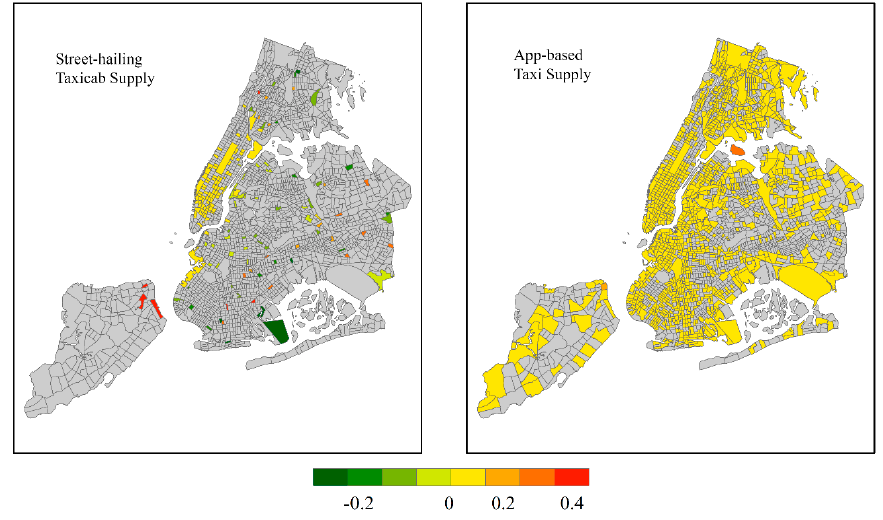
Figure 5. Impacts of vehicle supply on hourly app-based taxi ridership. (Note grey regions mean the corresponding impacts are statistically insignificant.). corresponding impacts are statistically